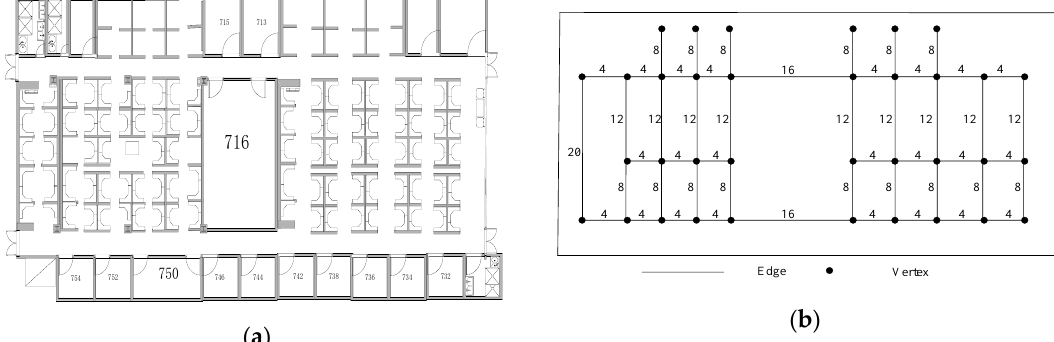
Figure 15. Undirected weighted graph model. ( a ) indoor floor-plan; ( b ) undirected weighted graph model.